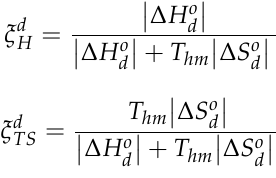
Figure 4. Experimental solubility data correlated by the van ‘t Hoff equation for different amino acids in the eutectic solvent ( a ) and in its 50:50 (wt:wt) mixture with water ( b ). Legend: glycine; β -alanine; L-proline; trans-4-hydroxy-L-proline; L-lysine·HCl; L-arginine; L-cystine.